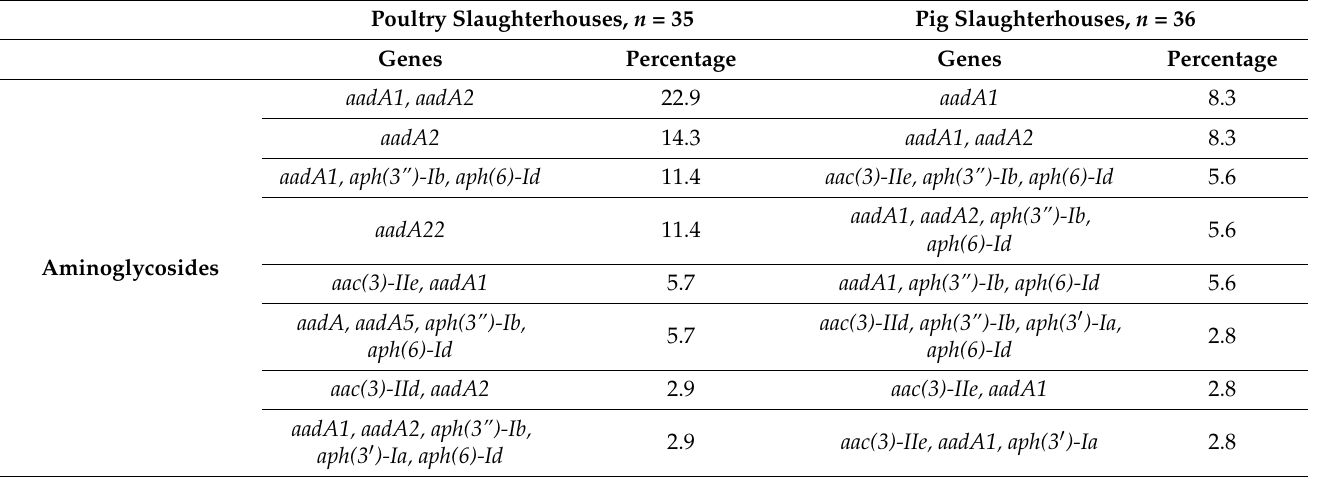
Table 1. Antibiotic resistance genes and their combinations detected in selected E. coli isolates recovered from wastewater and process waters from poultry and pig